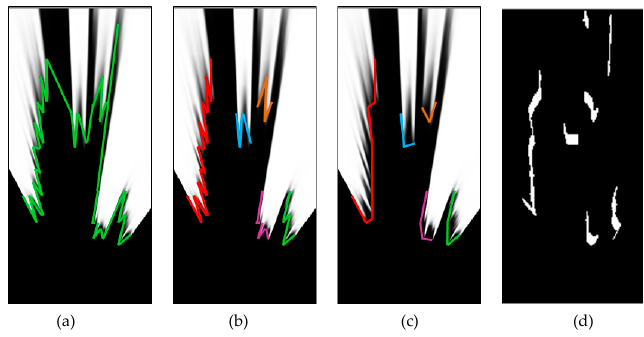
Figure 5. Generating the convex scans from the segmented bird’s-eye view image: ( a ) The scan lines generating by identifying transition areas along polar rays; ( b ) clustering of the scan lines; ( c ) convex hulls of the clusters; ( d ) binary image generated from extracted scans. Algorithm 1 : Extraction of convex scan lines